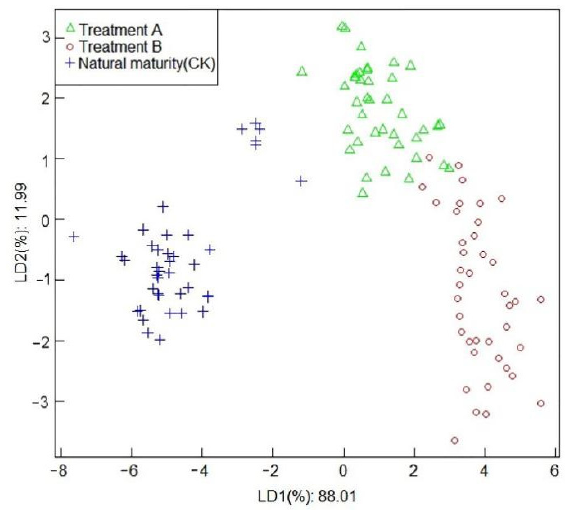
Figure 8. Classification result based on linear discriminant analysis (LDA).